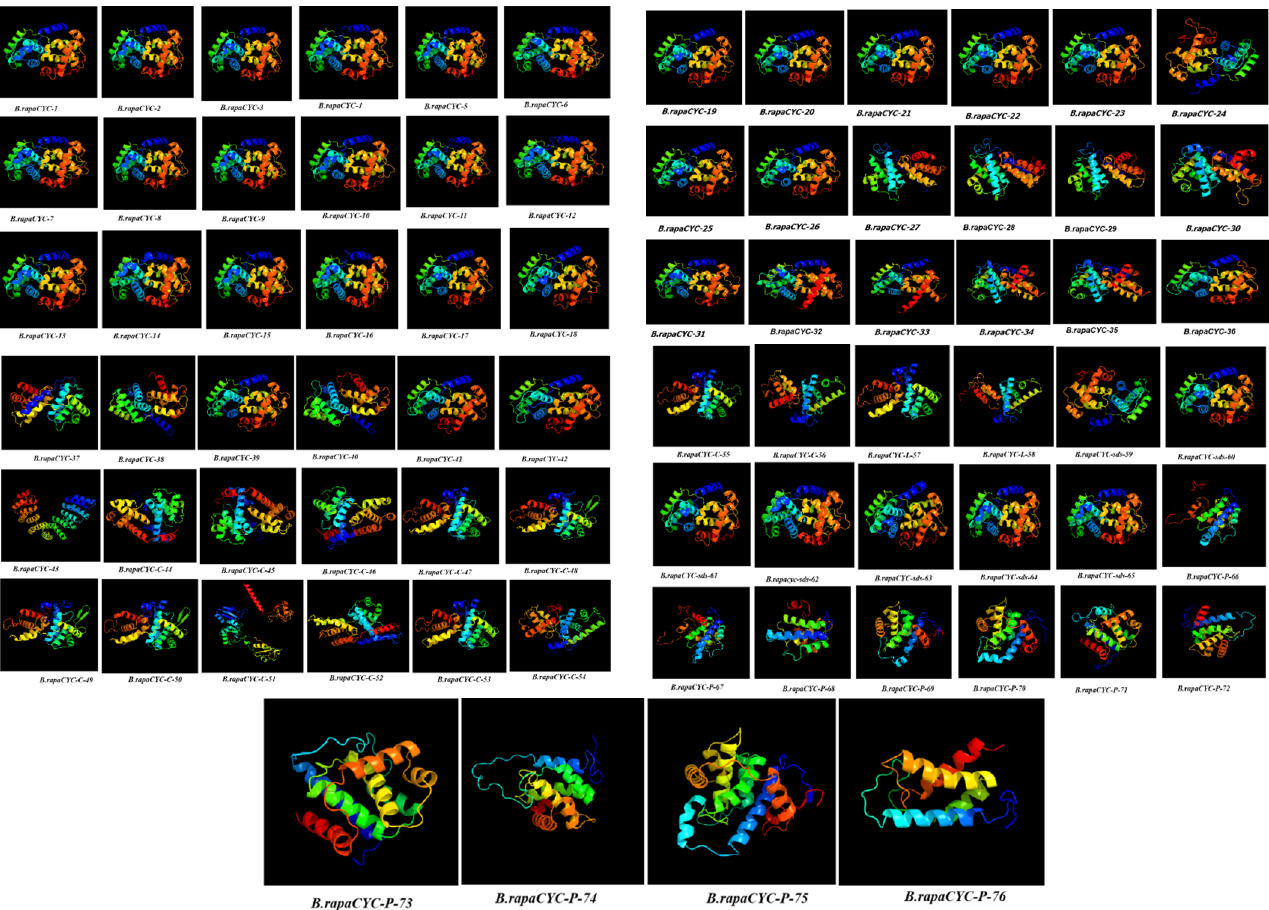
Figure 6. Predicted 3D-Structure of the cyclin gene family members in Brassica